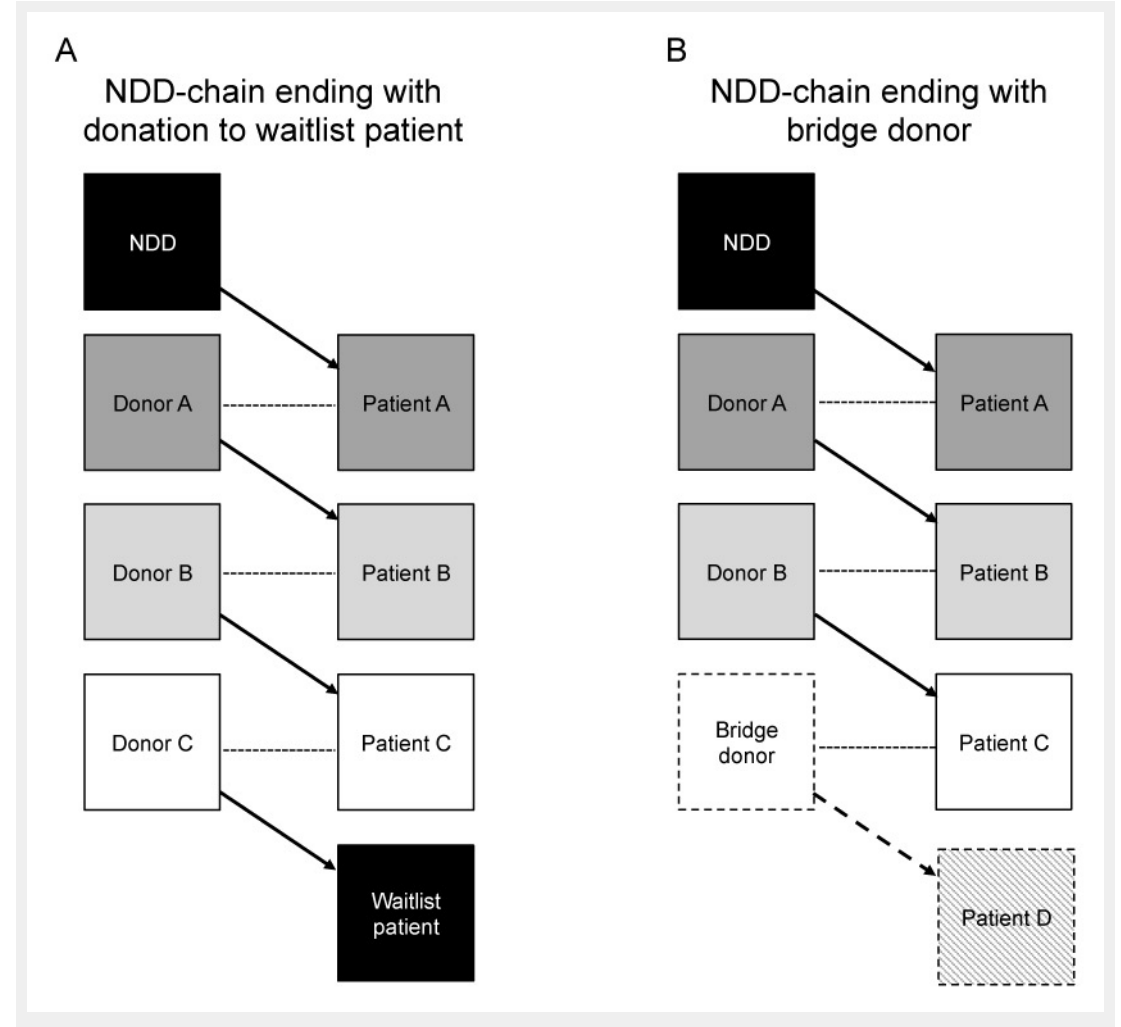
Figure 3 Multi-way exchanges beginning with a non-directed donor (NDD) and including multiple donor-recipient pairs. The closed chain donation model ends with the final donor donating to a patient on a deceased-donor wait list (A). The open chain model ends with a bridge donor that will start a new chain of transplants